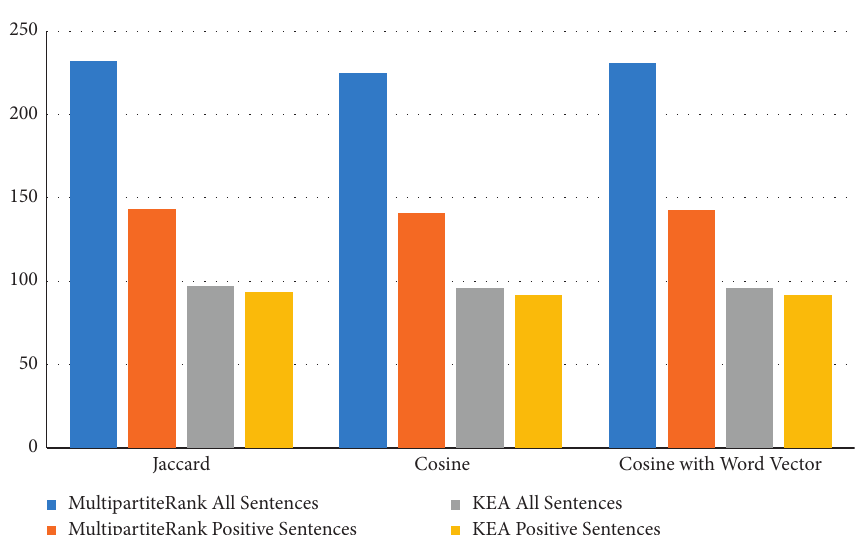
Figure 5: Comparative scores of similarity calculation run times for positive and all sentences employing MultipartiteRank and KEA keyword extraction